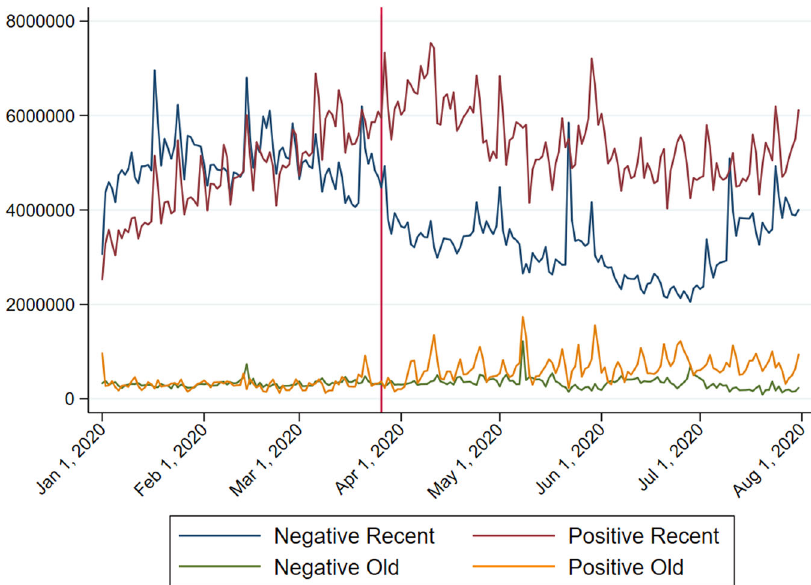
Fig. 8 Changes in the total number of plays of four types of songs. Source: Author ’ s illustration of Spotify data.